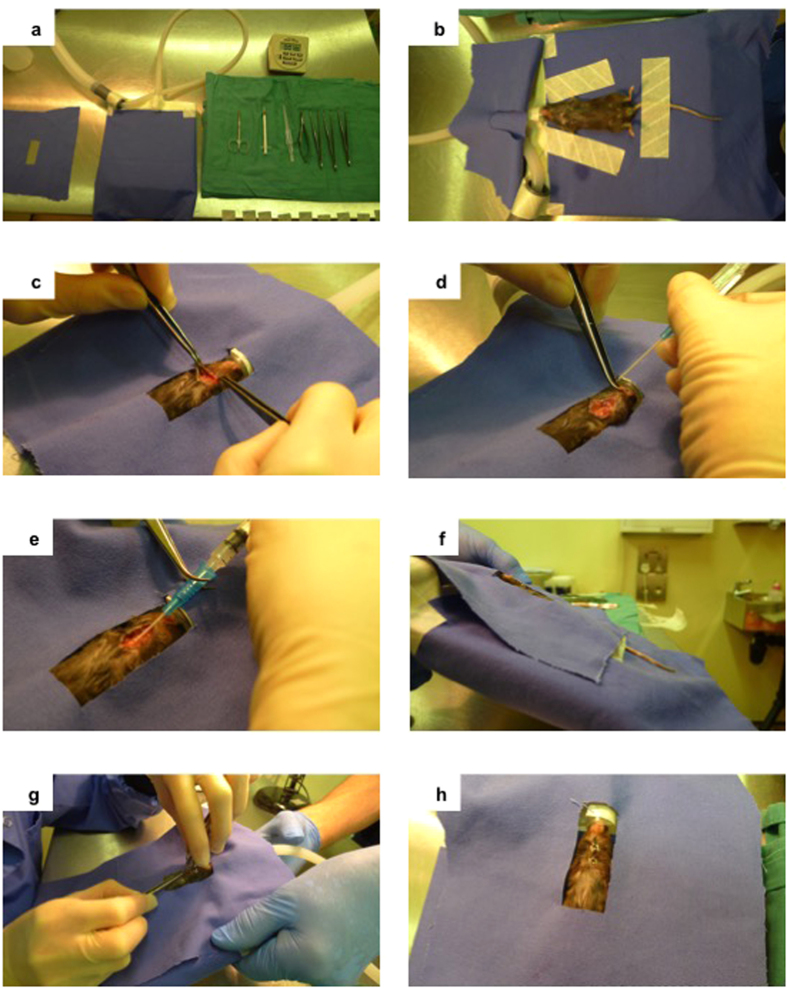
Technique for intra-tracheal instillation of agar beads using inhaled anaesthesia.(a) Sterile surgical equipment set-up required for instillation. (b) Following anesthesia administered via isofluorane inhalation in an anesthesia box, animals were transferred to the surgical board and maintained under anaesthesia via nose cone. (c) Midline neck incision and careful division of soft tissues to expose trachea. (d) Insertion of 22G intravenous cannula into trachea, while extending neck using traction on lower jaw. (e) Injection of 50 μl of beads/PBS via cannula. (f) Elevation of anaesthetized animal on surgical board head-up to 45-degrees for a timed 1-minute in order to aid full inspiration of beads. (g) Closure of incision with surgical staples. (h) Completed closure of incision.